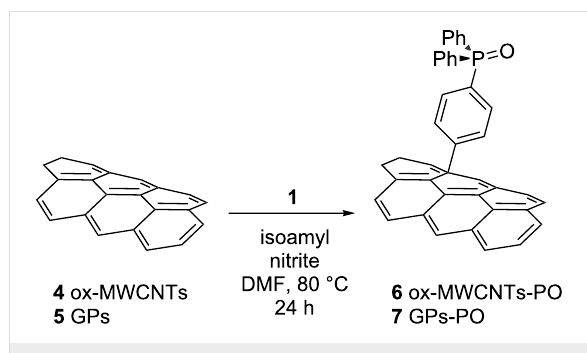
Such work led to the production of phosphine oxide substituted CNMs. A limited number of works describe the introduction of phosphorous moieties onto CNMs. Muleja et al. synthesized